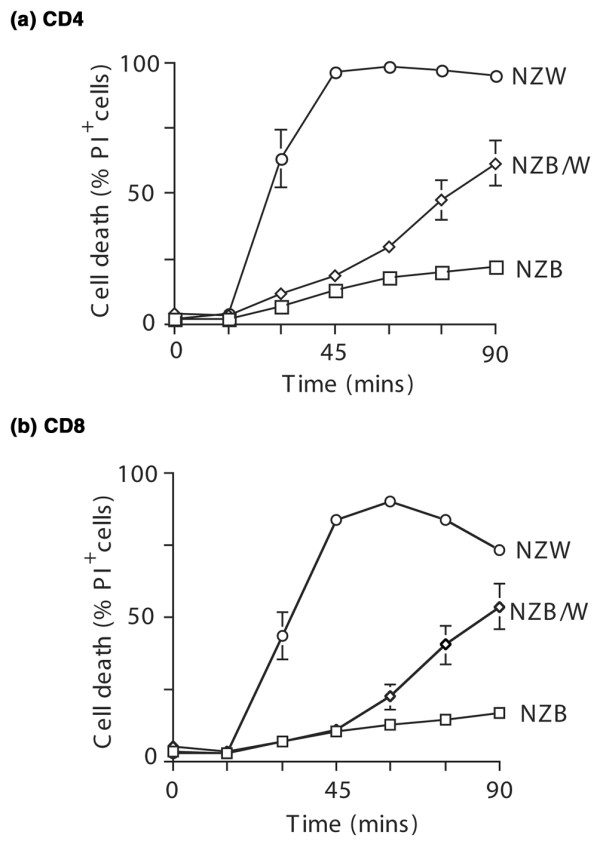
P2X7-stimulated lymphocyte programmed cell death (PCD). Lymphocytes from New Zealand Black (NZB) mice, New Zealand White (NZW) mice and (NZB × NZW)F1 (NZB/W) mice were stained with anti-CD4APC and anti-CD8FITC, and were equilibrated with propidium iodide (PI). Panels show the mean percentage (± standard deviation, n = 5) of dead cells (those taking up PI) as assessed by flow cytometry before (t = 0), and at 15-min intervals subsequent to, stimulation of the P2X7 receptor with 2'-3'-O-(4-benzoylbenzoyl)-adenosine 5'-triphosphate. (a) CD4+ cells, and (b) CD8+ cells. NZB, open squares; NZW, open circles; NZB/W, open diamonds.